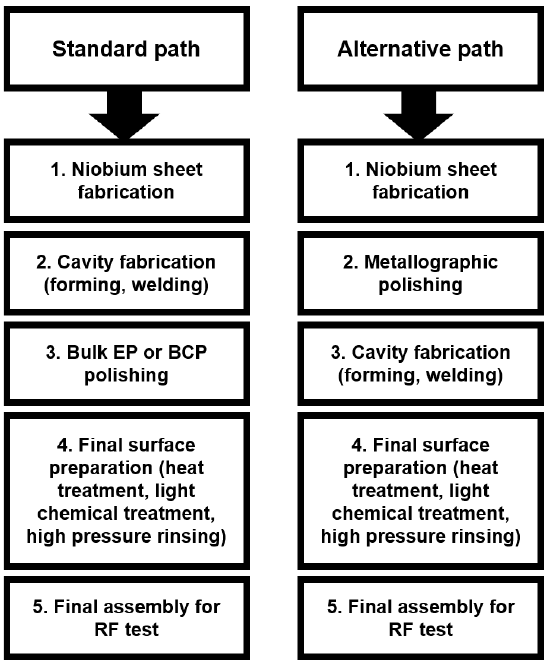
Figure 3. Main steps in cavity life cycle for standard and new suggested procedure.